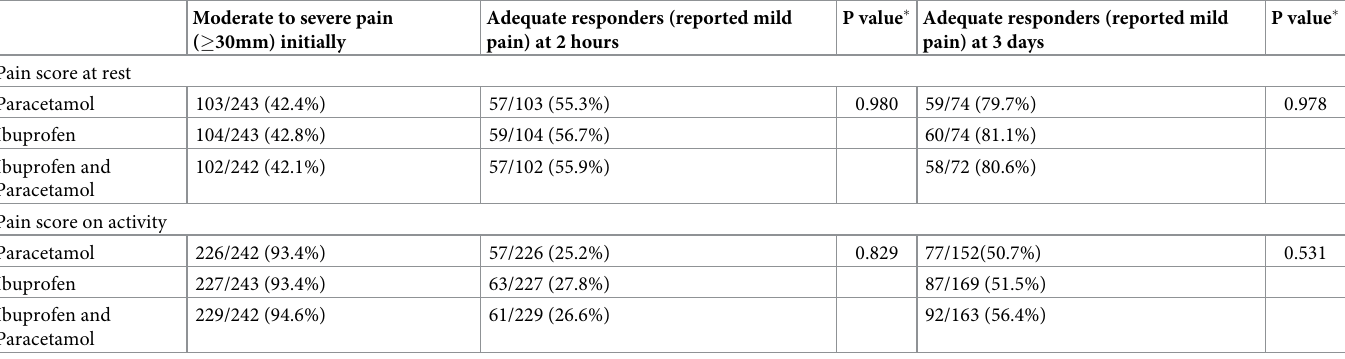
Table 3. Proportion with ‘no worse than mild pain’ at baseline, 2 hours, 3 days and the proportion of adequate responders.